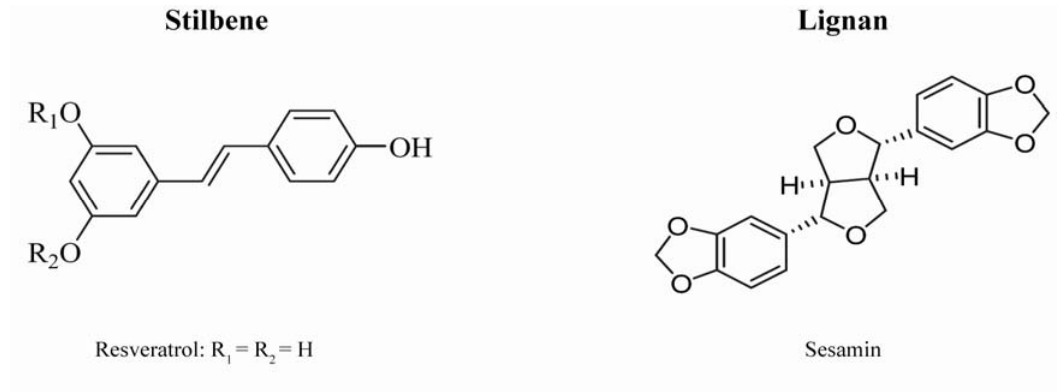
Figure 2. Structures of stilbenes and